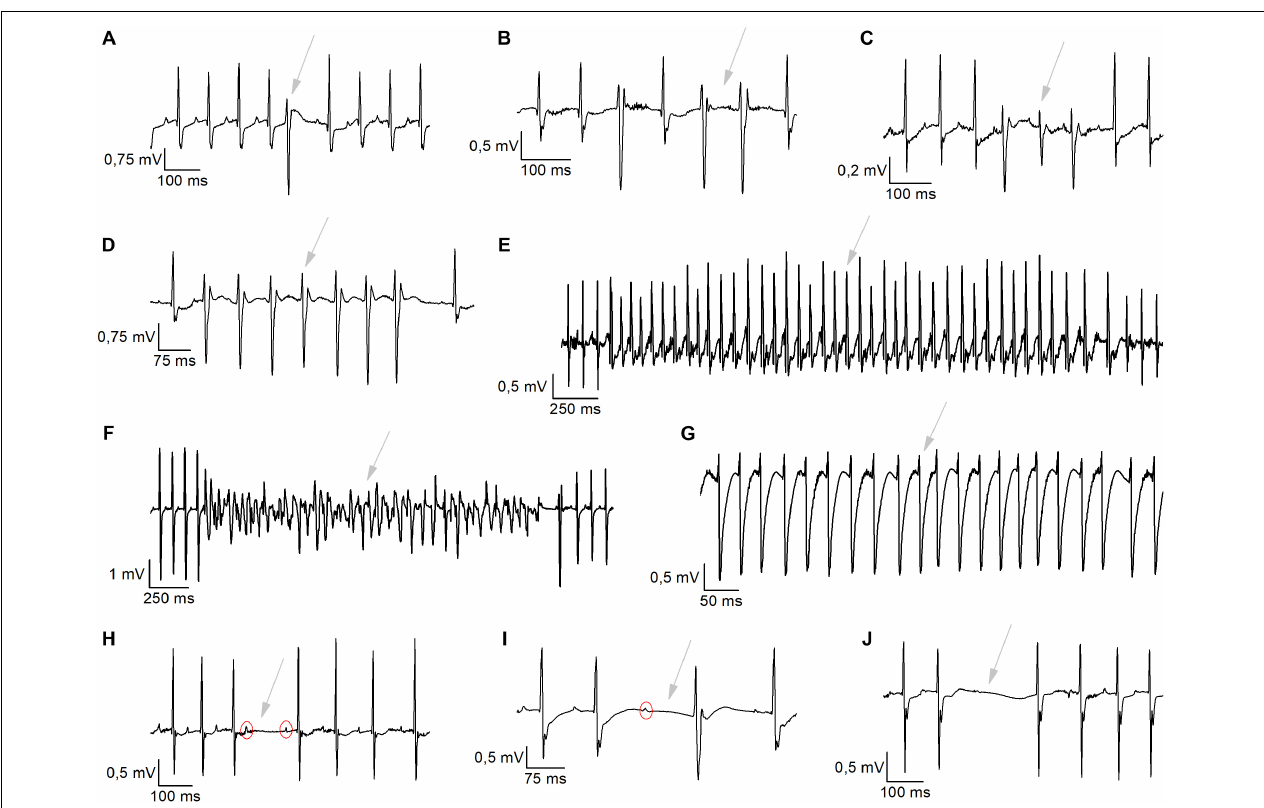
FIGURE 5 | Typical arrhythmic incidents exhibited during nocturnal baseline measurements or during exercise-induced β -adrenergic stress. (A–G) Ventricular arrhythmias were detected like single ventricular ectopic (VEB) beats (A) , Couplet VEBs (B) , Triplet VEBs (C) , non-sustained ventricular tachycardia (D) , sustained ventricular tachycardia (E) , ventricular fibrillation (F), and idioventricular rhythm (G) . (H–J) Representative traces of conductions disturbances, like 2nd-degree atrioventricular blocks (H) , AV-block + escape beats (I), and sinoatrial arrests (J) . TABLE 1 | Conduction parameters from freely moving WT, WT + Luc, WT + TRPM4, TRPM4 − / − , TRPM4 − / − + Luc, and TRPM4 − / − + TRPM4 mice (WT: n = 27, WT + Luc: